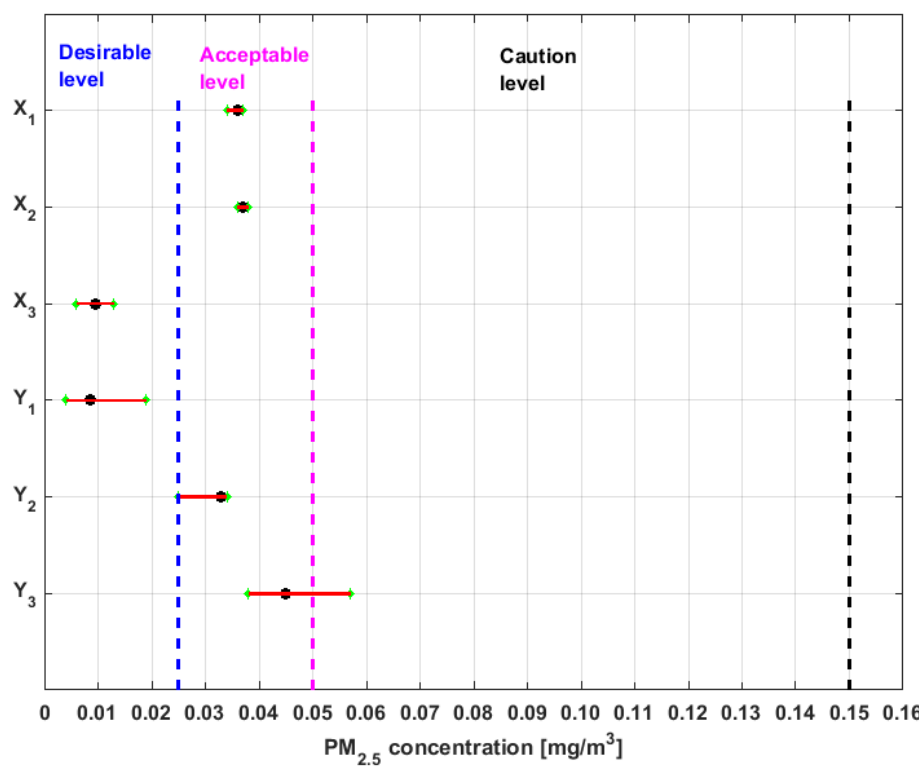
Figure 10. Medians, 95% nonparametric confidence intervals for the medians, and the bands that delimit the three lowest categories of air pollution by PM 2.5 concentrations in Quito. Median: Black circle; Ends of the intervals: Green diamond.